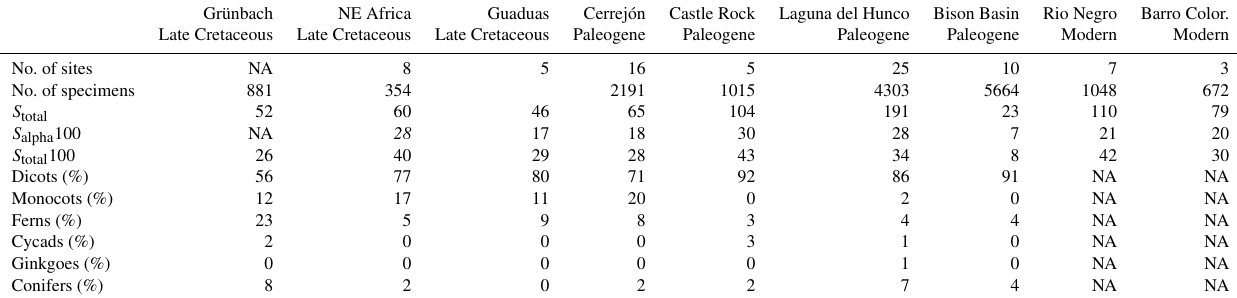
Table 1. Diversity and composition. Information on the sites is given in the Supplement. S total , number of species in all samples; S alpha 10, number of species in sample rarefied to 10 specimens; S alpha 100, number of species in sample rarefied to 100 specimens; and S total 100, number of species in all samples rarefied to 100